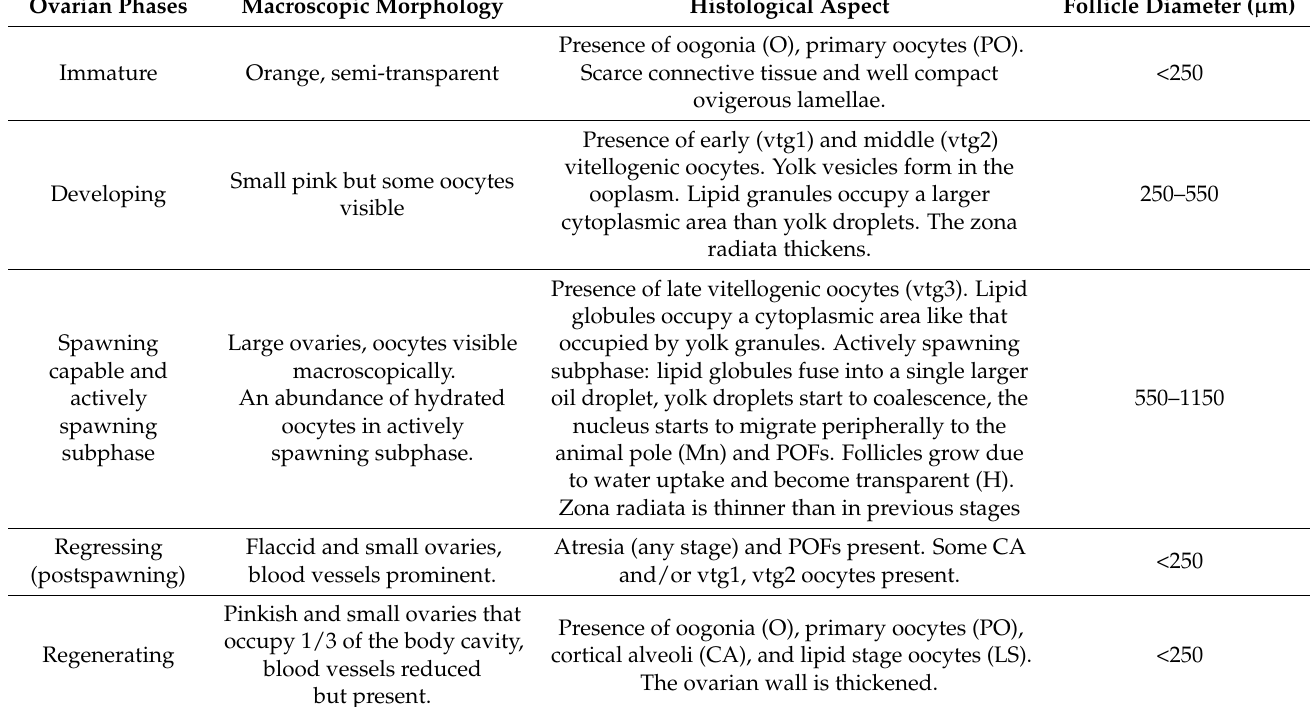
Table 1. Criteria used to determine the maturational status of European hake